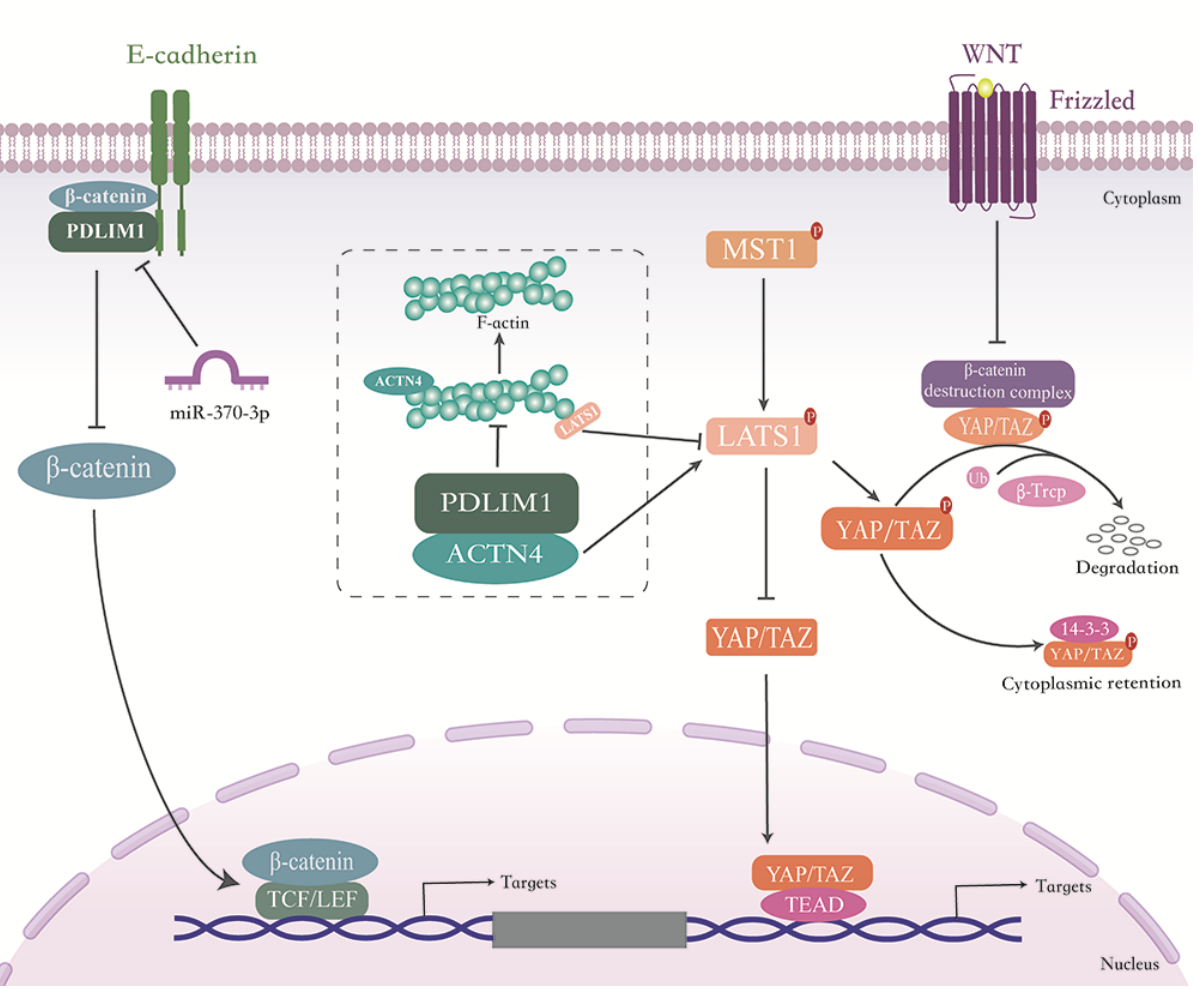
FIGURE 3: Schematic model of PDLIM1-mediated cancer progression. PDLIM1 expression is down-regulated in CRC cells, thus reducing the binding of β -catenin/E-cadherin complex and subsequent β -catenin nuclear translocation to initiate EMT and metastatic process. In HCC cells, loss of PDLIM1 leads to the formation of excessive F-actin, further inducing LATS1 dephosphorylation, inactivating the Hippo pathway and promoting HCC metastasis. Moreover, PDLIM1 expression is regulated by miRNAs such as miR-370-3p, subsequently affecting down- stream